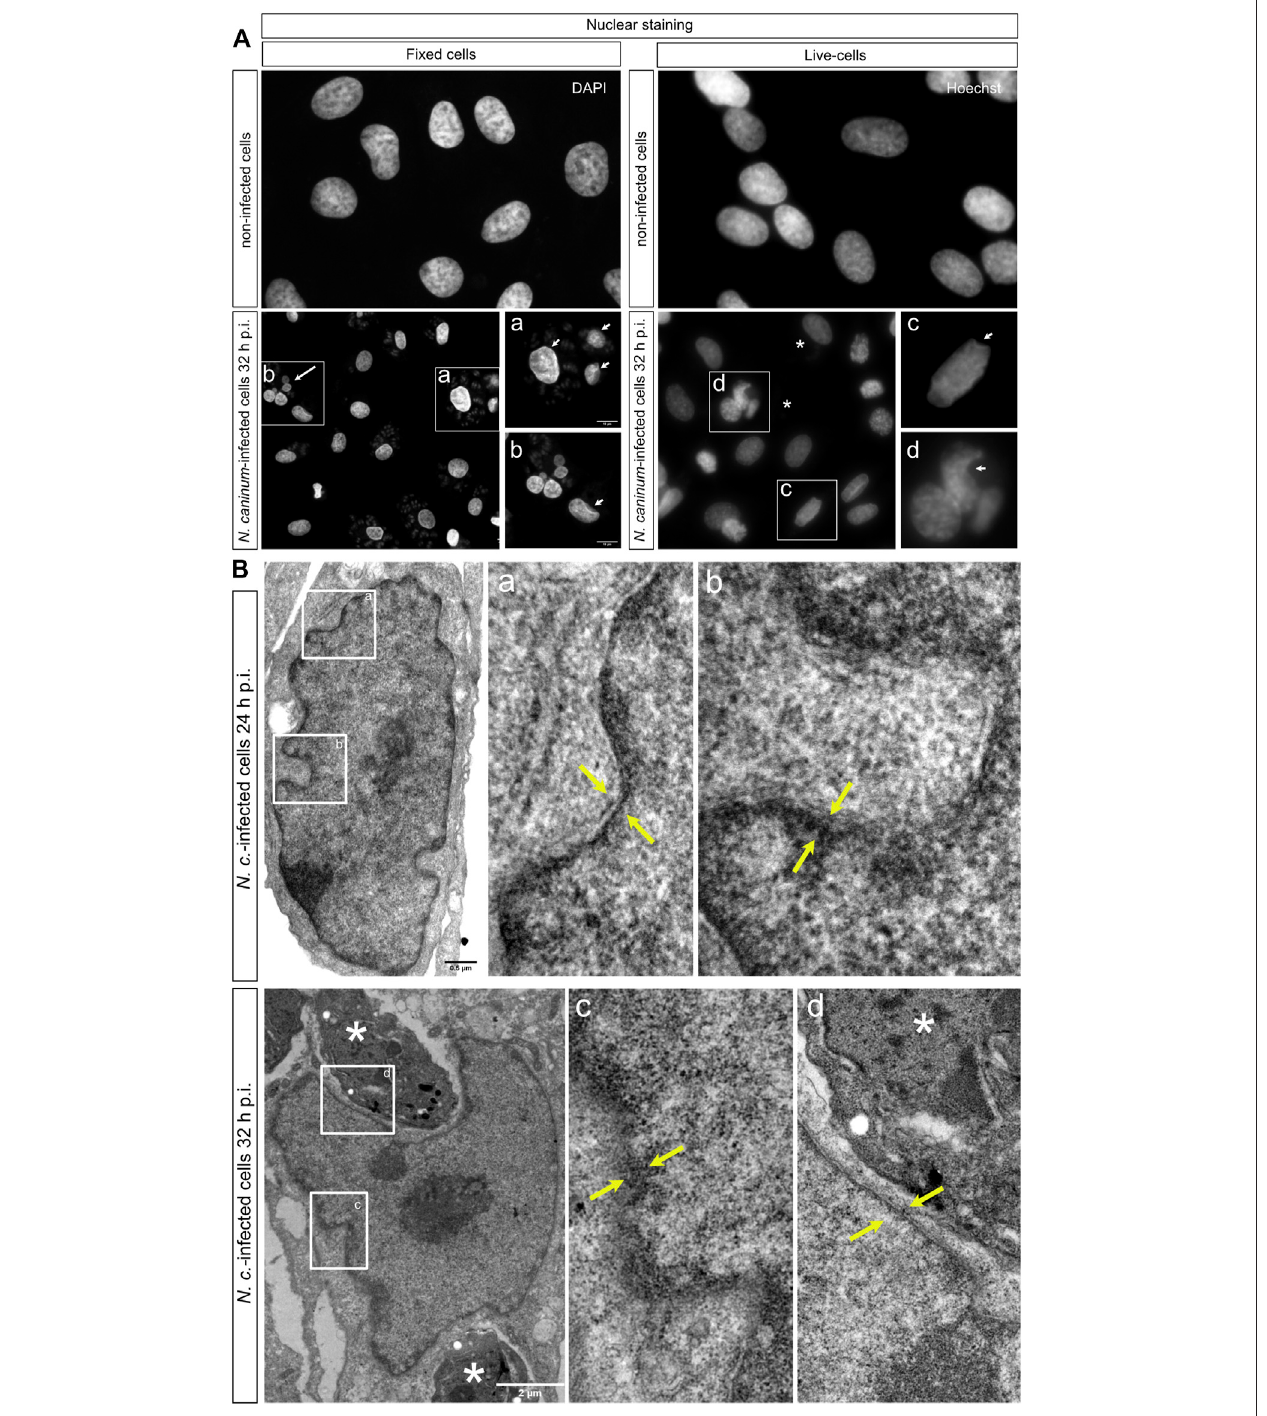
FIGURE4 | Morphology of cell nucleiin N. caninum -infected BUVEC layers. (A) Three BUVECbiological replicates were infected with N. caninum tachyzoites, and thehostcellnuclearshapewascomparedbetweenPFA- fi xedandlivingcellsafter32 hp.i.After fi xation,cellswerepermeabilizedandstainedwithaDAPIprobetoallow host cell nucleus recognition as well as to detect the nucleus of the parasite (little gray dots surrounding the host cell nucleus). Live-cell imaging was developed with Hoechstnuclearstaining,whichallowsagoodresolutionofthehostcellnucleibutde fi cientparasiticnuclei,forthat,thelocalizationoftheparasite isshownwithan asterisk. (B) TEM analysis of N. caninum- infected host cells shows a nuclear compartment with depression and altered by tachyzoite localization (asterisk). The inspection of the nuclear membrane displayed zones without the detection of double membranes (space between yellow arrows). (a, b) Inset of the image into the left corner in order to show in more detail the nuclear membrane structure. The scale bar represents 5 µm.